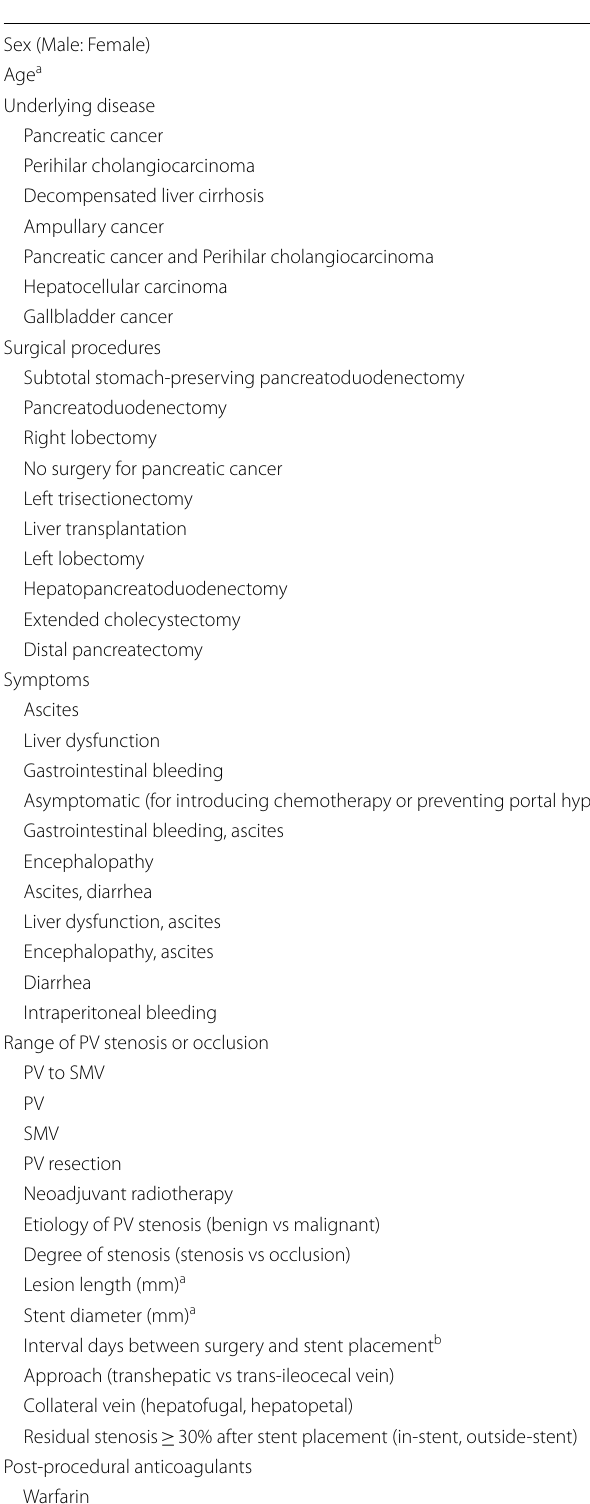
Table 2 Patient characteristics ( n 34). (Location: After the sub-heading “Short-term outcomes of PV stent placement” in the =